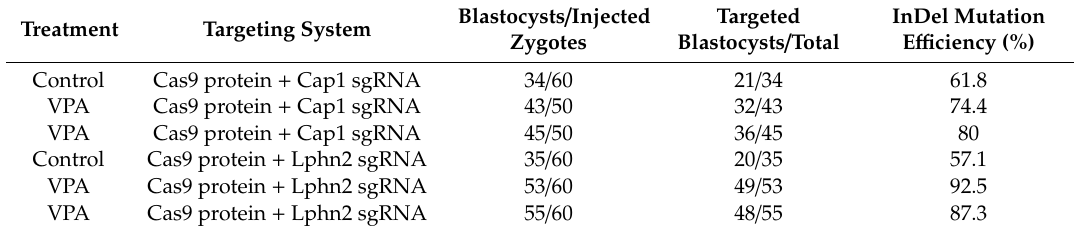
Table 1. E ffi cient CRISPR / Cas9-mediated gene targeting in mouse embryos. Cas9 protein and sgRNA targeting Cap1 or Lphn2 were injected into the cytoplasm of mouse embryos. The zygotes were cultured with or without VPA in M2 media 1 h before the microinjection, and cultured in KSOM medium with or without VPA until the blastocysts stage (3.5 days of culture) and analyzed by PCR and Sanger sequencing.